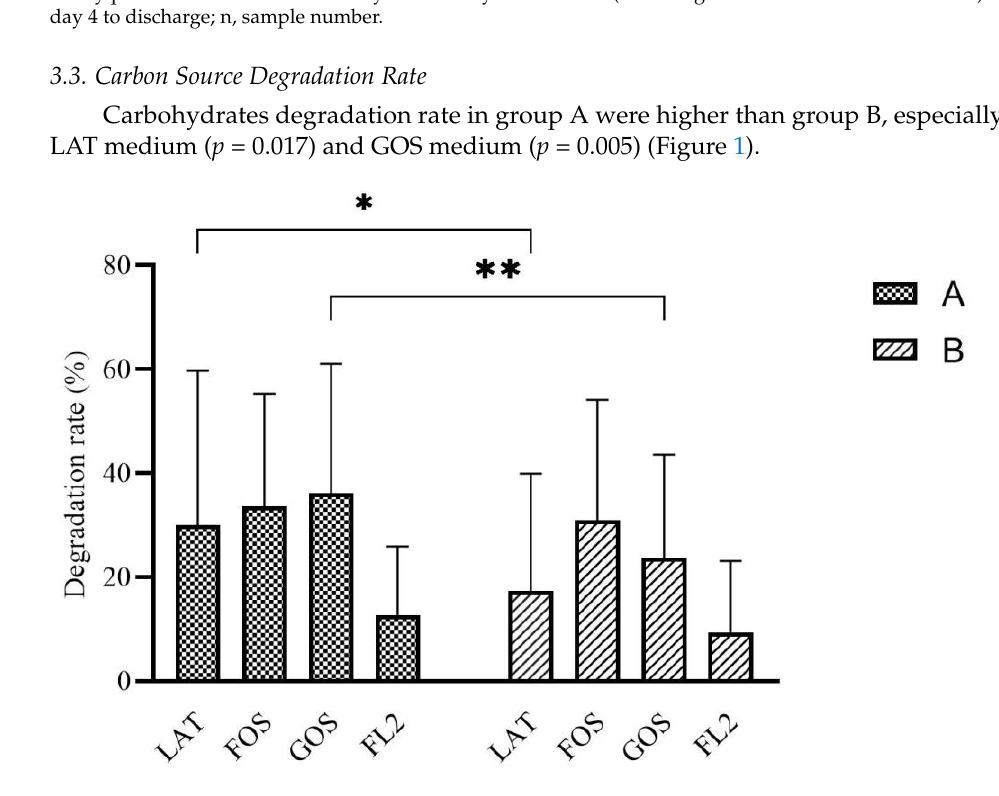
Figure 1. The rate of carbon source degradation by in vitro fermentation modeling system based on different initial feeding methods. Group A, preterm infants fed by human milk, including mother’s own milk and DHM; group B, preterm infants fed by preterm formula at first 3 days and fed by human milk (including mother’s own milk and DHM) from day 4 to discharge. LAT, lactose; FOS, fructooligosaccharide; GOS, galactooligosaccharide; FL2, 2 (cid:48) -fucosyllactose. Data are shown as median with interquartile and error bars represent 5–95 percentile (* p < 0.05, ** p <